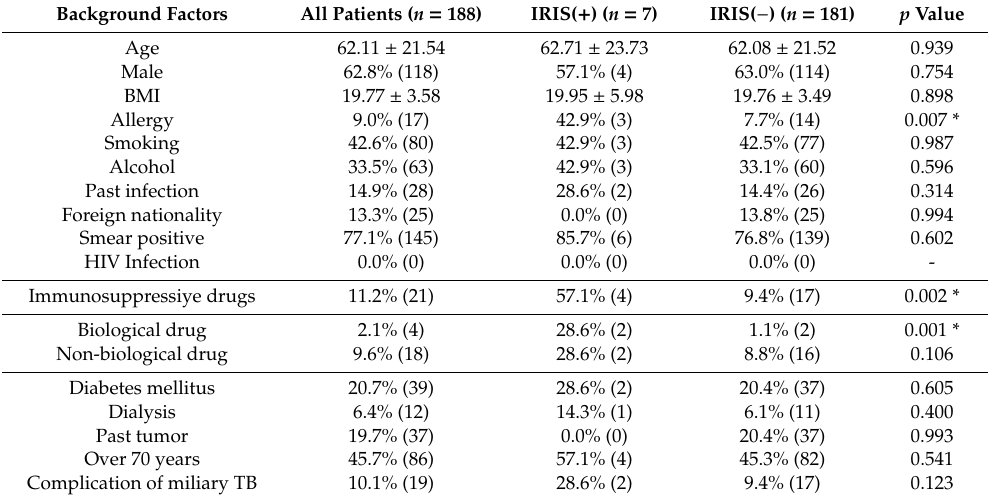
Table 2. Background factors with or without immune reconstitution inflammatory syndrome